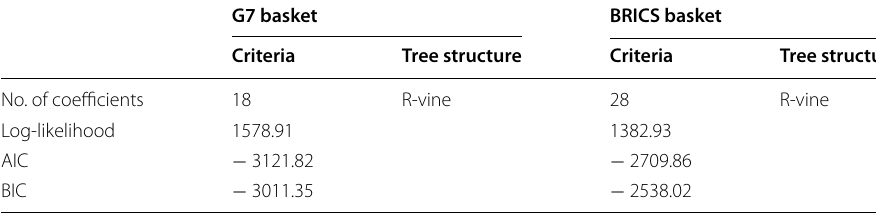
Table 5 R-vine copula results for the full